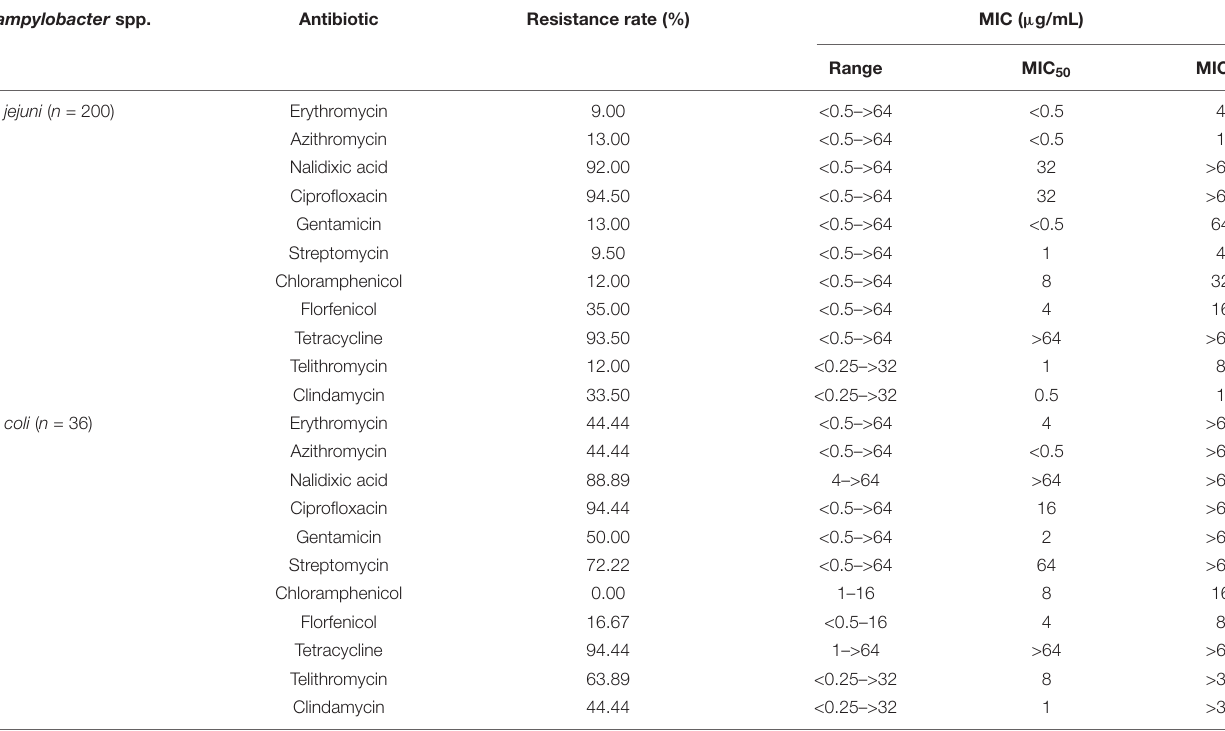
TABLE 2 | Resistance rates (percentages) and minimum inhibitory concentrations (MICs) of human Campylobacter spp. isolates in Beijng. Campylobacter